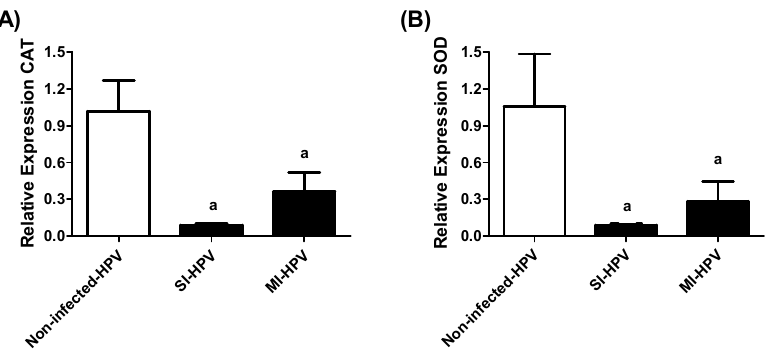
Figure 3. Relative gene expression of CAT and SOD in study groups. ( A ) Relative gene expression of catalase (CAT), ( B ) superoxide dismutase (SOD) in non-infected group, and groups with single infection (SI-HPV) or multiple infections (MI-HPV). Data are expressed as the means ± SD and were analyzed by one-way ANOVA. Significant difference is defined as p < 0.05. a Infected HPV group vs. non-infected group.